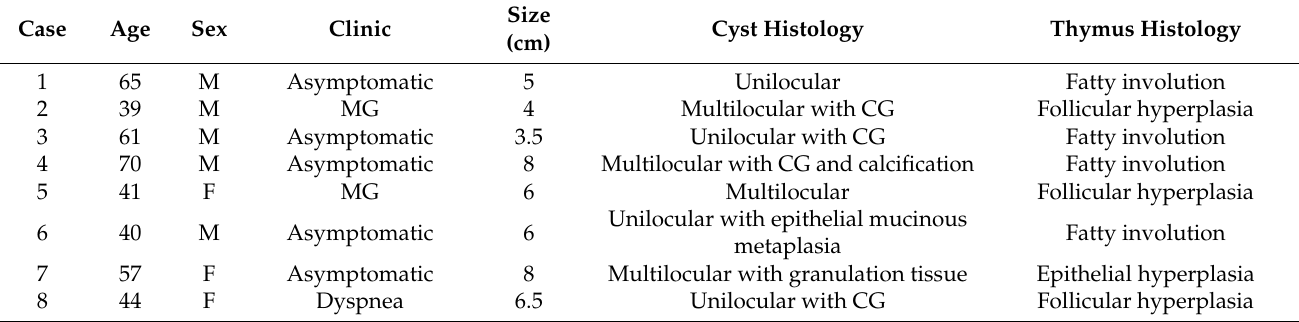
Table 1. Main clinical and histological features of 15 patients with thymic